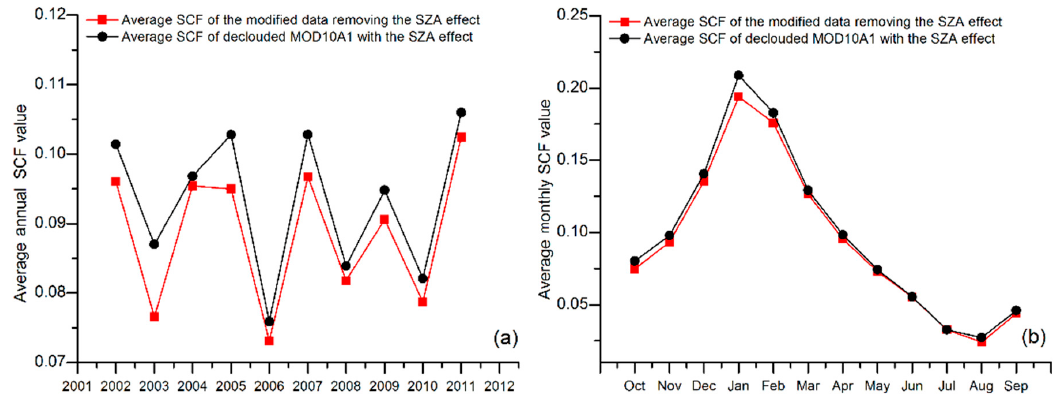
Figure 9. Comparison of average snow cover frequency (SCF) values obtained from modified data (red squares) and only de-clouded data statistics (black circles) on an ( a ) annual and ( b ) monthly basis for the 10 years between 2002 and 2011.